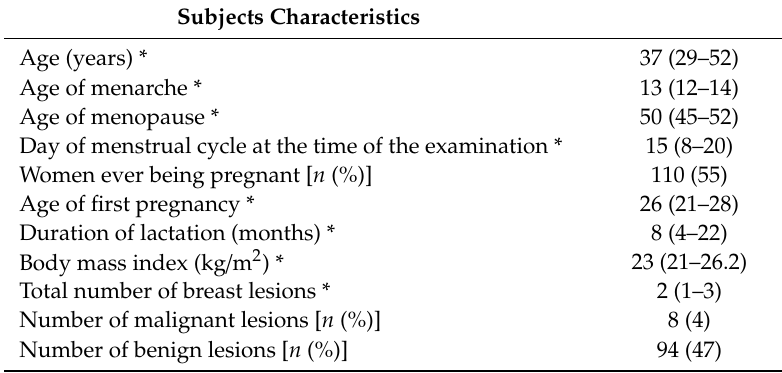
Table 2. Descriptive statistics of quantitative socio-demographic and clinical variables.